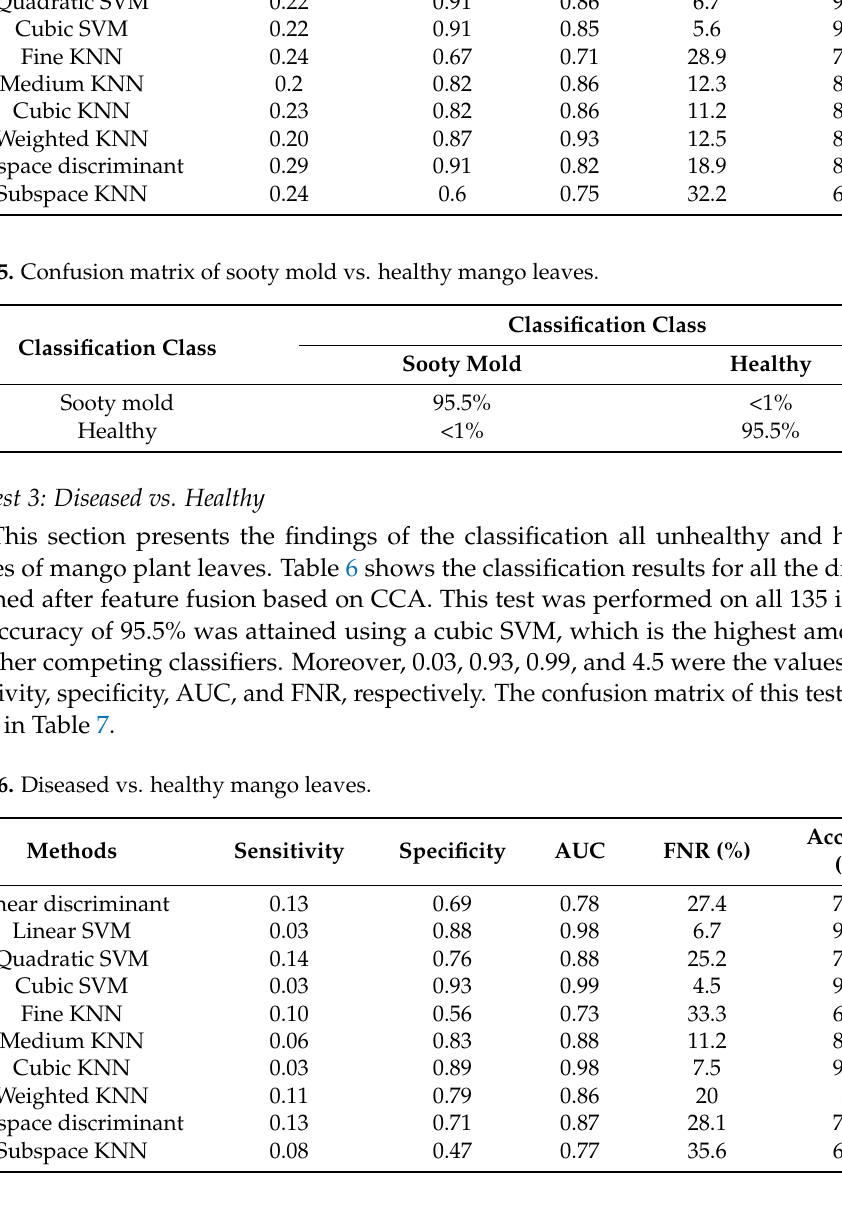
Table 7. Confusion matrix of diseased vs. healthy mango